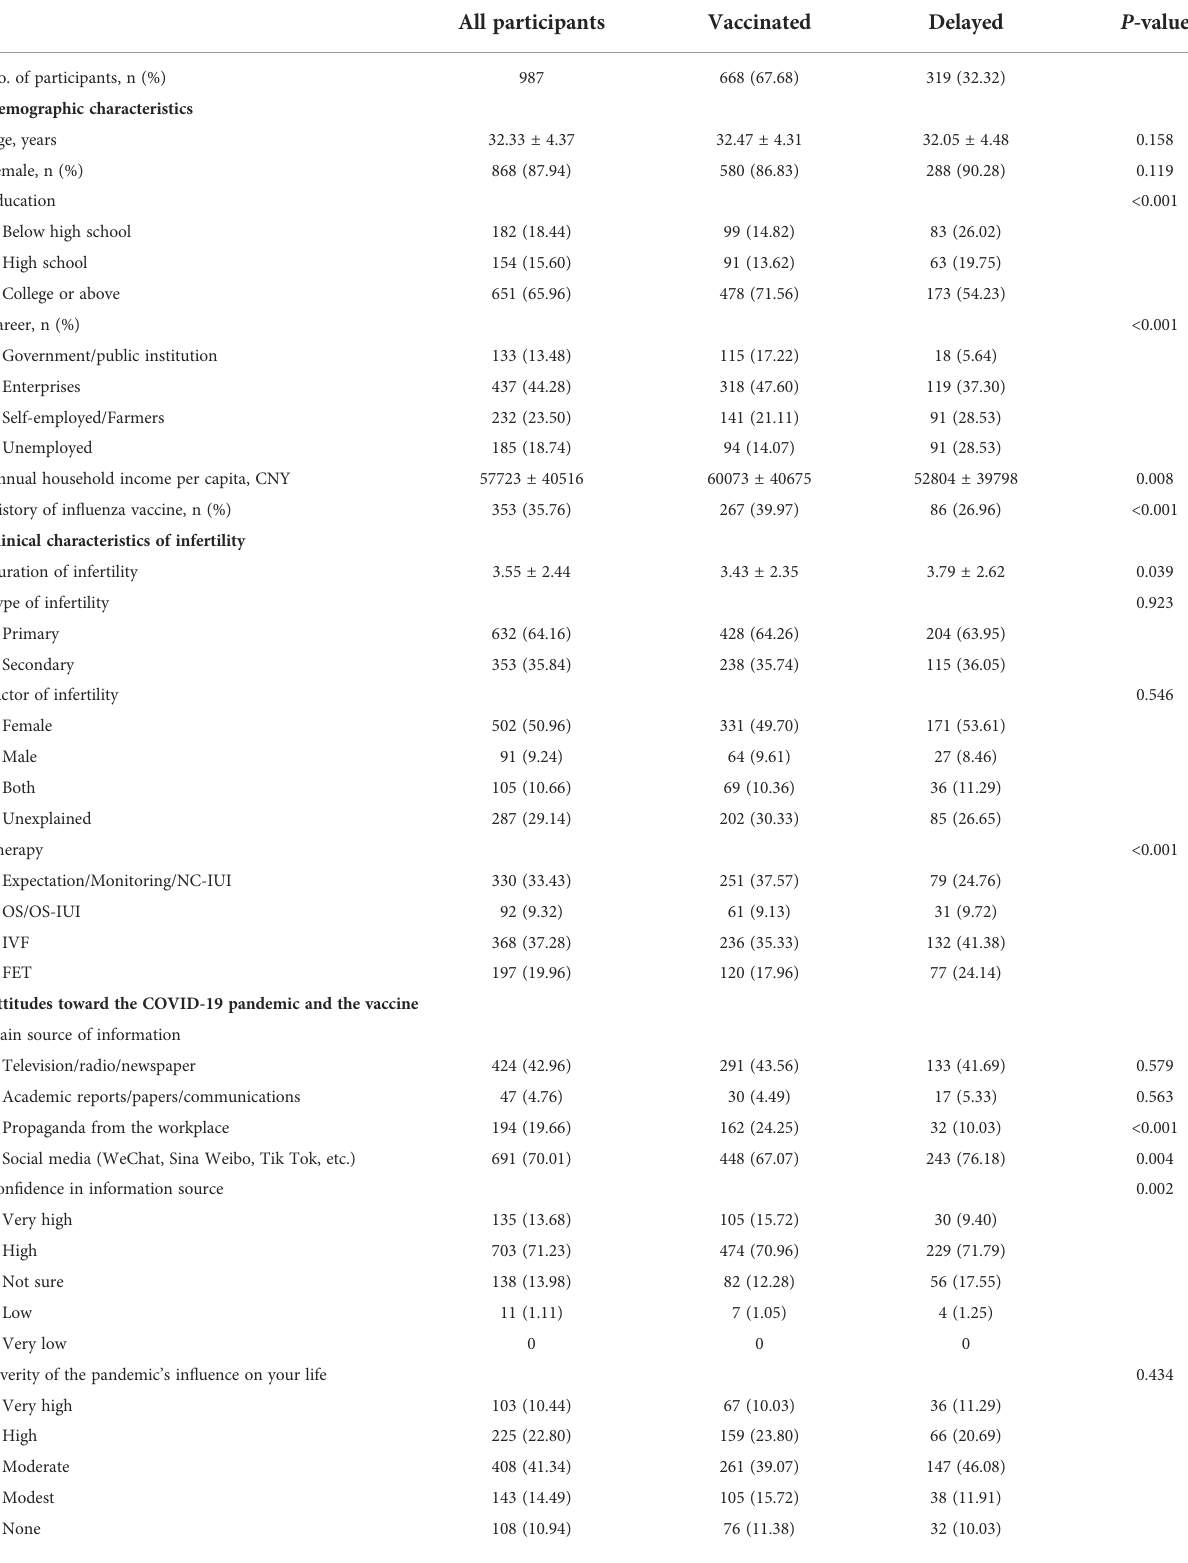
TABLE 1 Characteristics of participants by vaccination status of the primary COVID-19 vaccine.